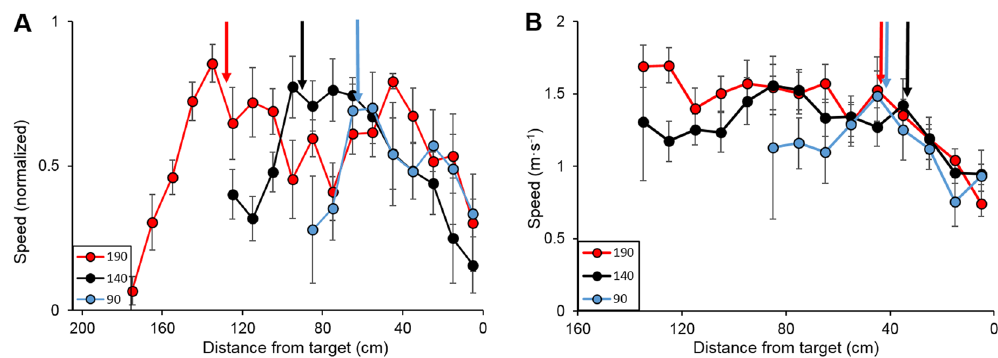
Figure 4. Bats reduce speed towards landing at a constant distance from target. Speed over distance to target for the 3 different takeoff distances. After initially increasing speed to reach a roughly stable ‘cruising’ speed (end of acceleration marked with correspondingly coloured arrows in panel A), the bats then decreased speed in preparation for landing. This was done at a constant distance from target (on average 50–60 cm), regardless of initial distance at takeoff (marked with arrows on panel B to simplify the presentation). Data are aligned to landing (distance ‘0’), shown are mean ± se. ( A ) Mean + se for all individuals. Data were normalized by dividing each bat’s average values for a given trial (target distance at takeoff) by the maximum value in that trial. ( B ) Non-normalized data from one individual. For two individuals the camera did not cover the first 30 cm of the flights to 190